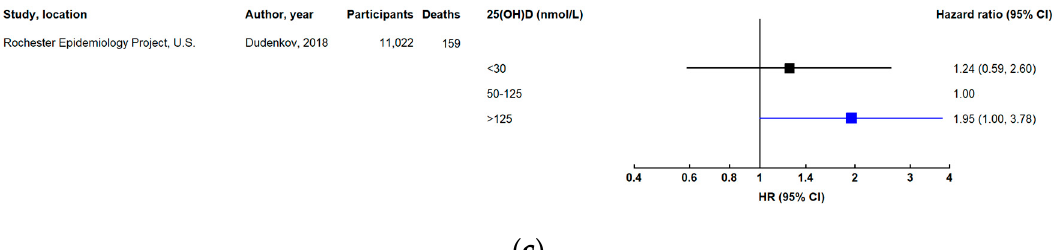
Figure 5. Results from prospective studies investigating respiratory disease mortality in relation to 25-hydroxyvitamin D (25(OH)D) concentration: ( a ) comparing low versus high concentrations categorically; ( b ) continuously, for a decrement in 25(OH)D concentration; ( c ) low (black) and high (blue) concentrations compared with levels in the middle of the 25(OH)D distribution. The squares represent hazard ratios and horizontal lines are the 95% confidence intervals. ˆ Relative risk was estimated in the Whitehall study. Axes are scaled differently in each panel to maximize the visualization of effect estimates.